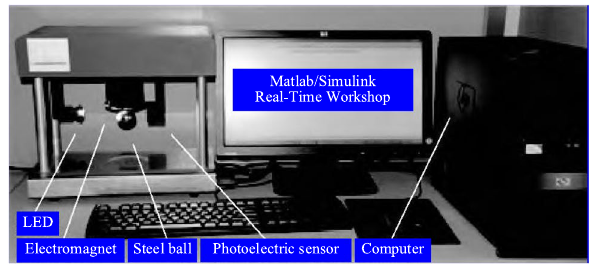
Figure 9. Experimental verification platform of the magnetic levitation ball system.